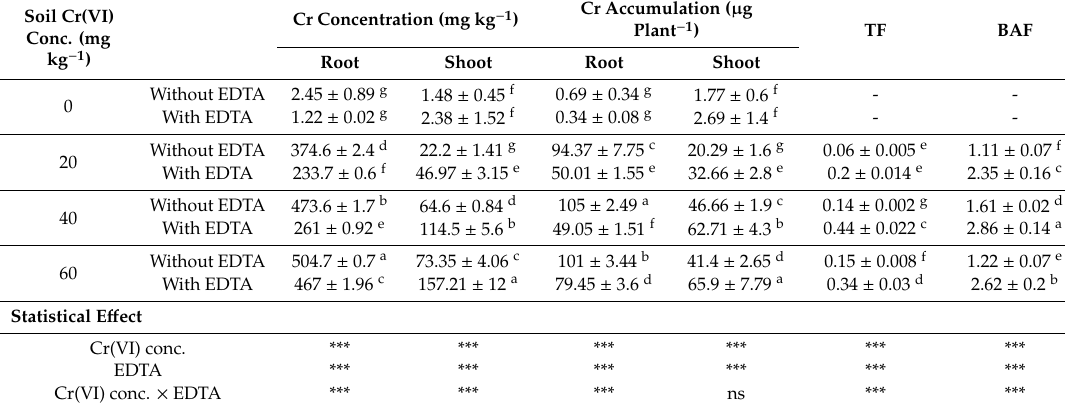
Table 2. Influence of various Cr(VI) concentrations in soil on Cr concentration and Cr accumulation in root and shoot, and Transfer factor (TF) and Bioaccumulation factor (BAF) of hybrid Napier grass with and without EDTA